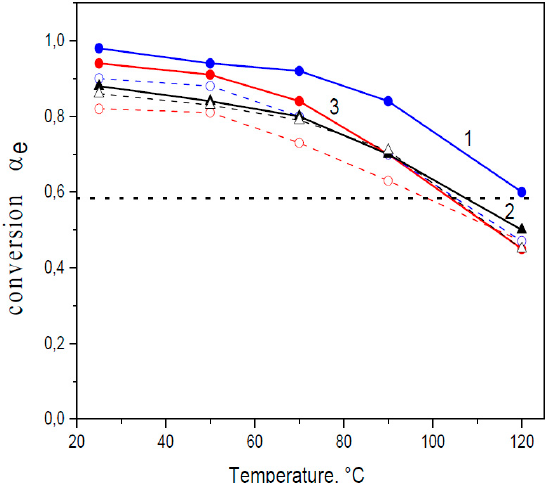
Figure 3. Equilibrium conversion α e in Diels–Alder (DA) systems F4D2000-bismaleimide as a function of temperature. Curves for different bismaleimides: 1 (blue)—HBMI; 2 (black)—PPO3BMI; 3(red)—DPBMI; — in bulk network ( (cid:8) ); - - - in solvent ( ). Dotted line . . . critical conversion (cid:35)